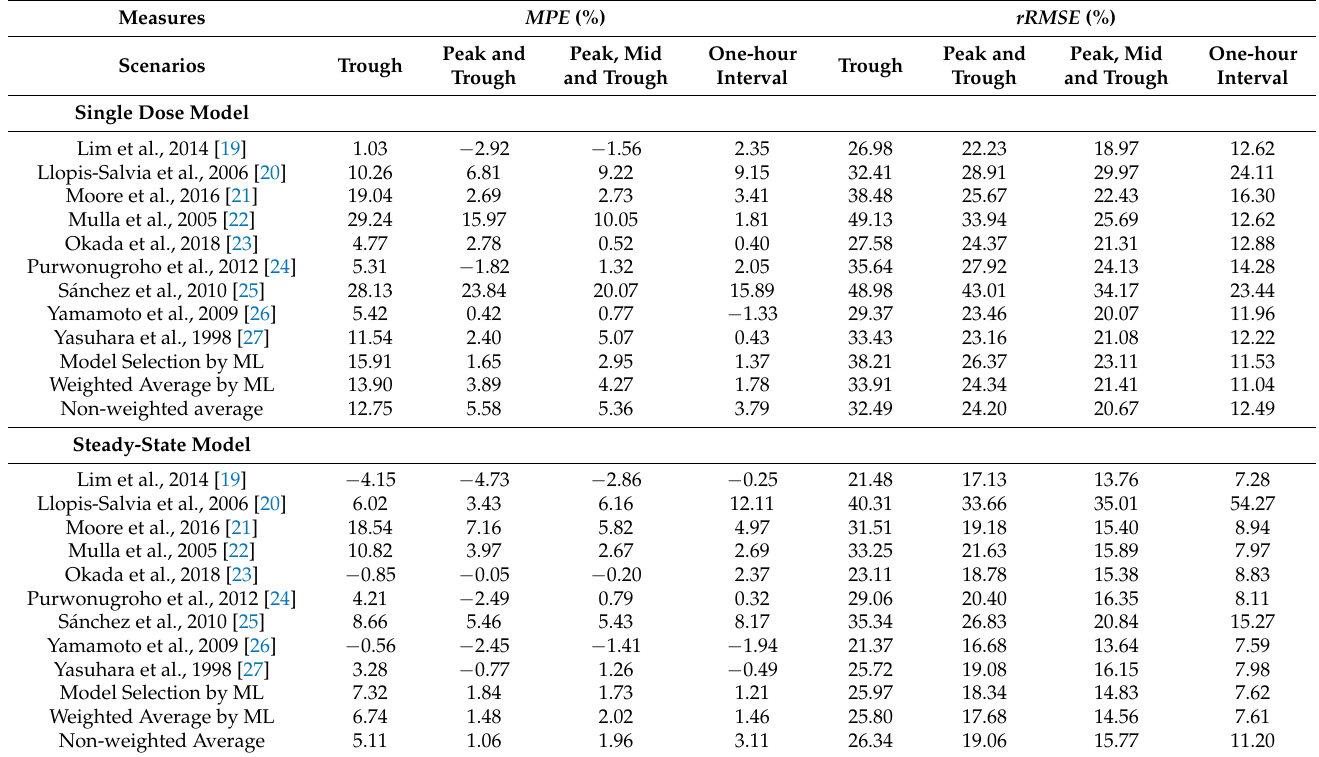
Table 3. The mean percent error ( MPE ) and relative root mean squared error ( rRMSE ) of the predicted AUC relative to the true AUC of each simulation scenario for external